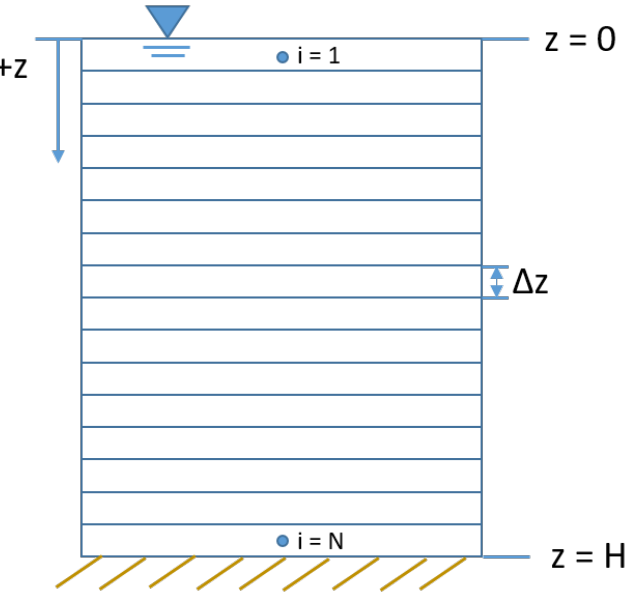
Figure 1. Layout of model grid used in cyanobacteria vertical migration models.